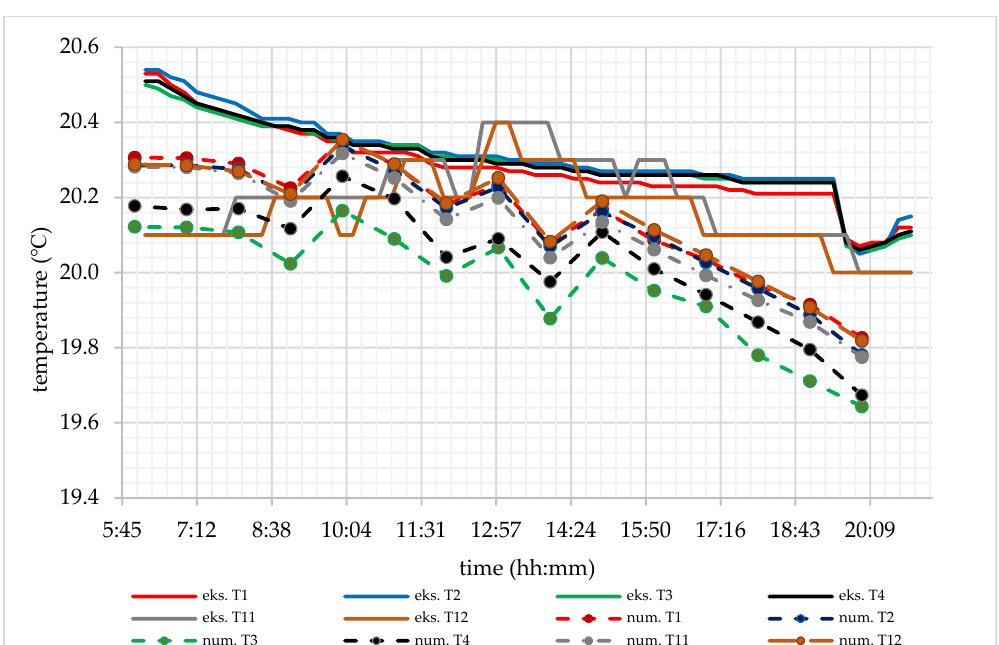
Figure 10. Distribution of the internal air temperatures—the experimental and digital studies.